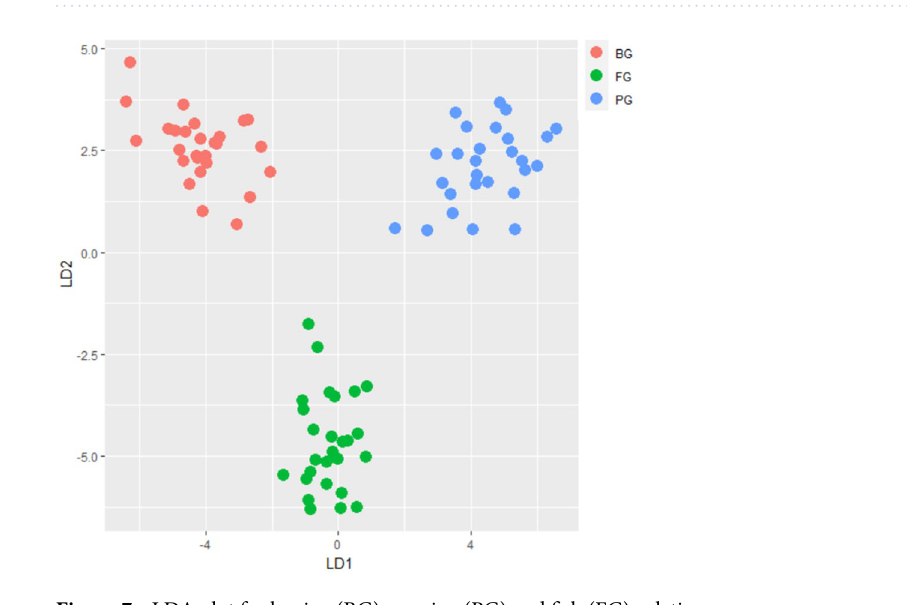
Figure 7. LDA plot for bovine (BG), porcine (PG) and fish (FG)